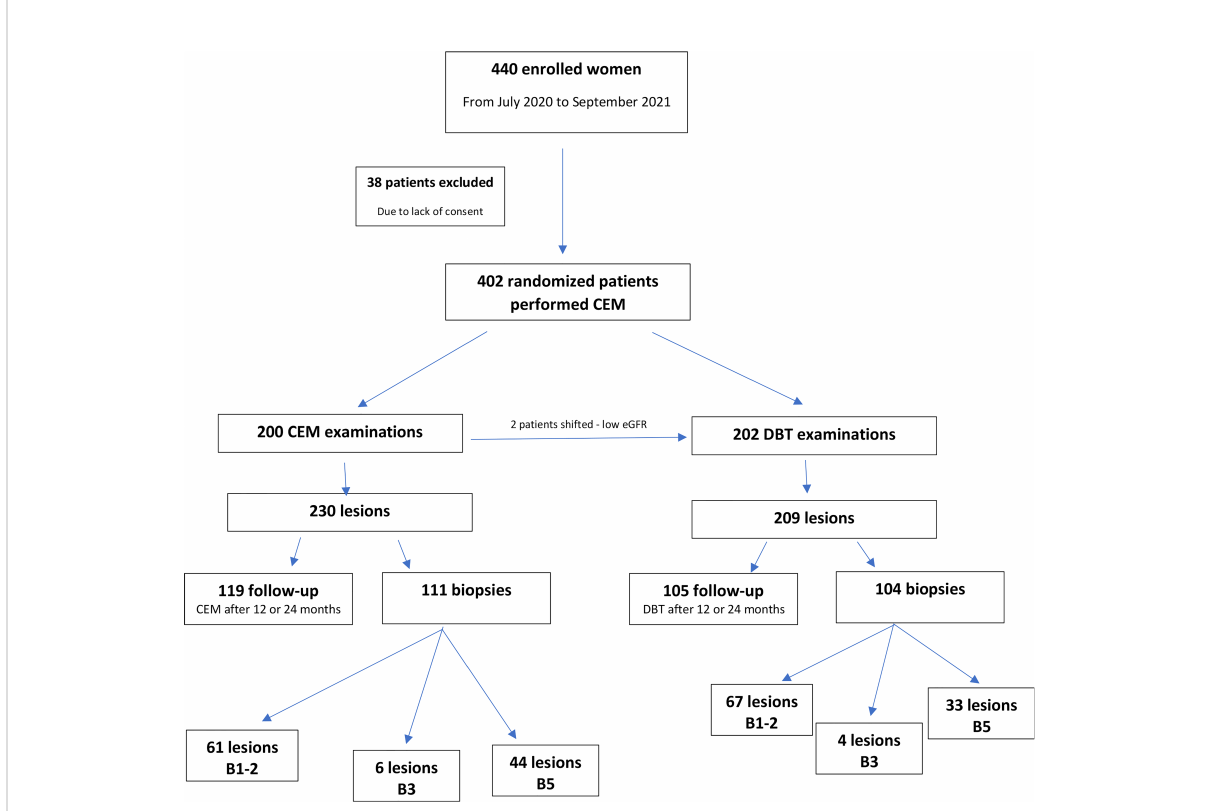
FIGURE 1 Study fl owchart presenting distribution of patients and lesions due to the histopathology results estimated by core needle biopsy or vacuum- assisted biopsy under ultrasound or mammography guidance